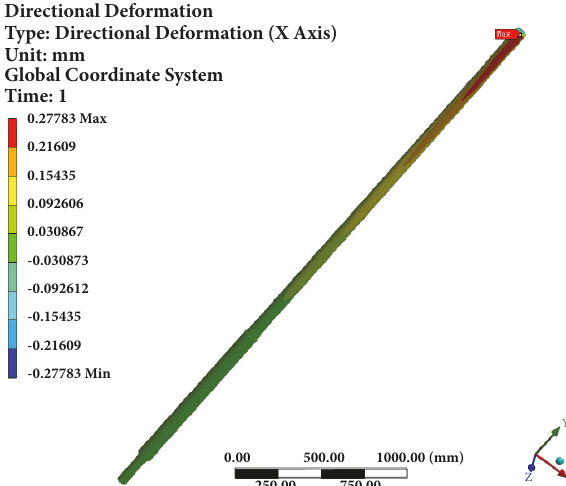
Figure 12: Displacement variation contour of axis.